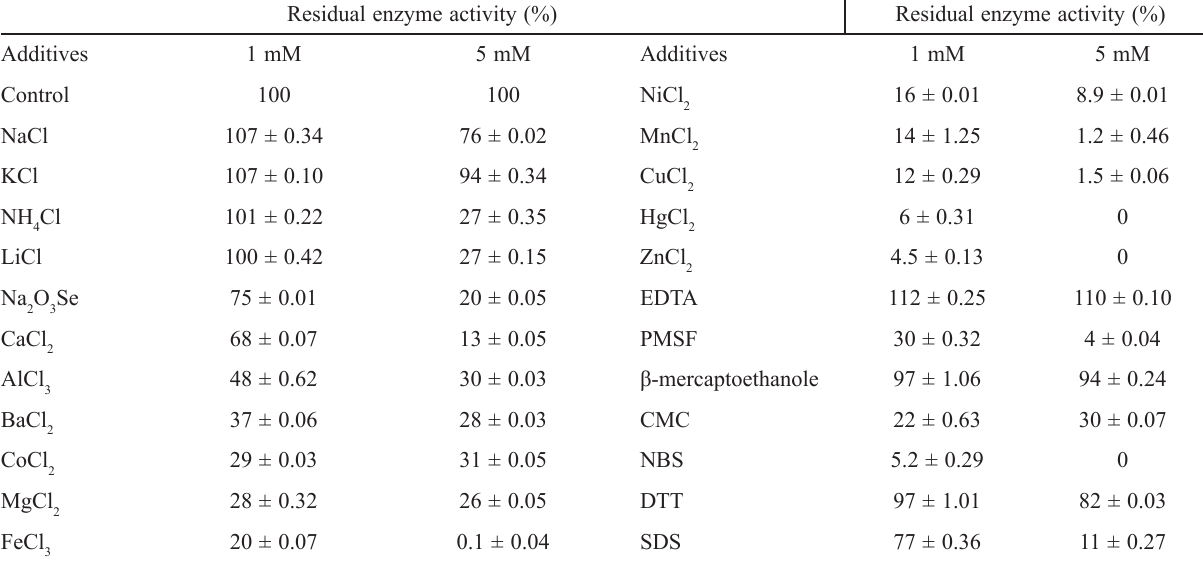
Table 2 – Effect of metal ions and inhibitors on enzyme activity Residual enzyme activity